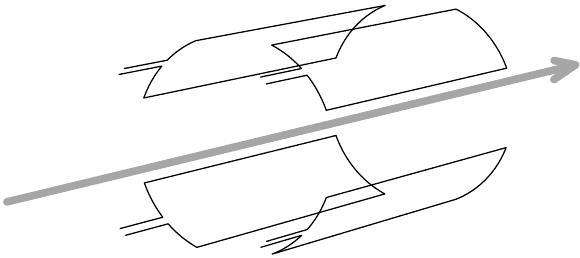
FIG. 1. Location of the induction loops. The arrow symbolizes the beam. For a centered, round beam no flux passes thru the loop and no signal is induced. Therefore, the quadrupole signal due to beam ellipticity is easy to detect. 1098-4402 (cid:1) 02 (cid:1) 5(7) (cid:1)